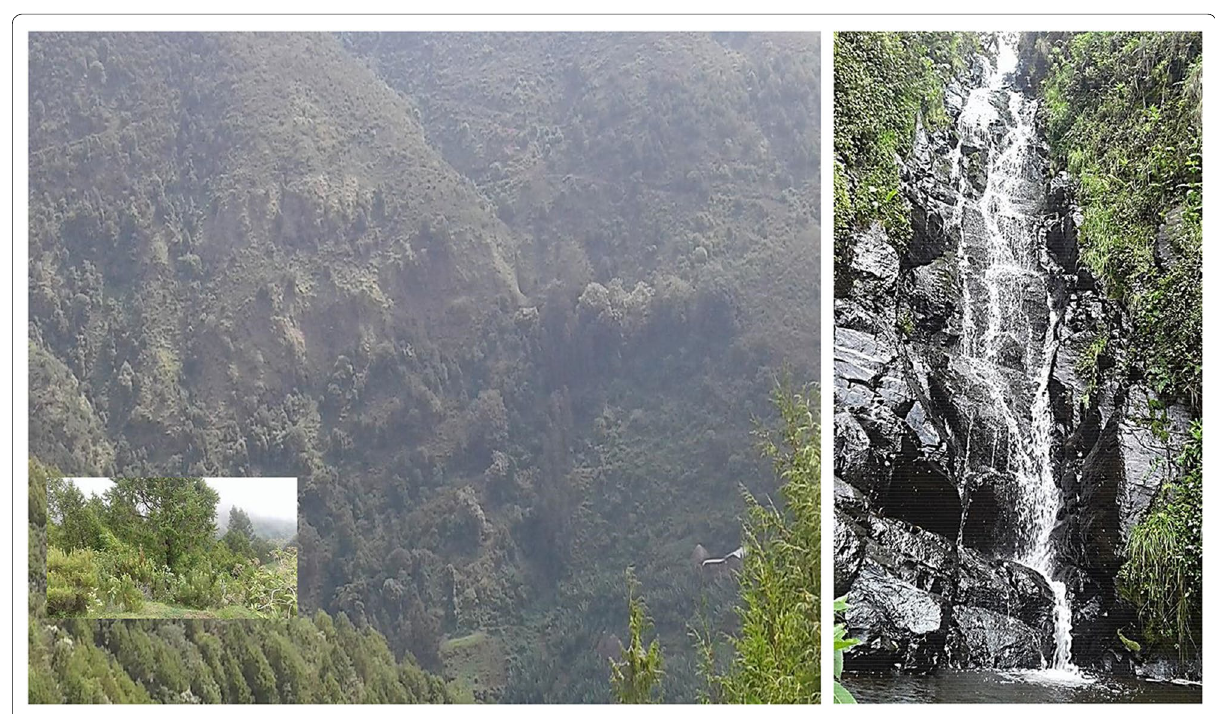
Fig. 3 Land cover in the resourceful upper zone of Meki river watershed